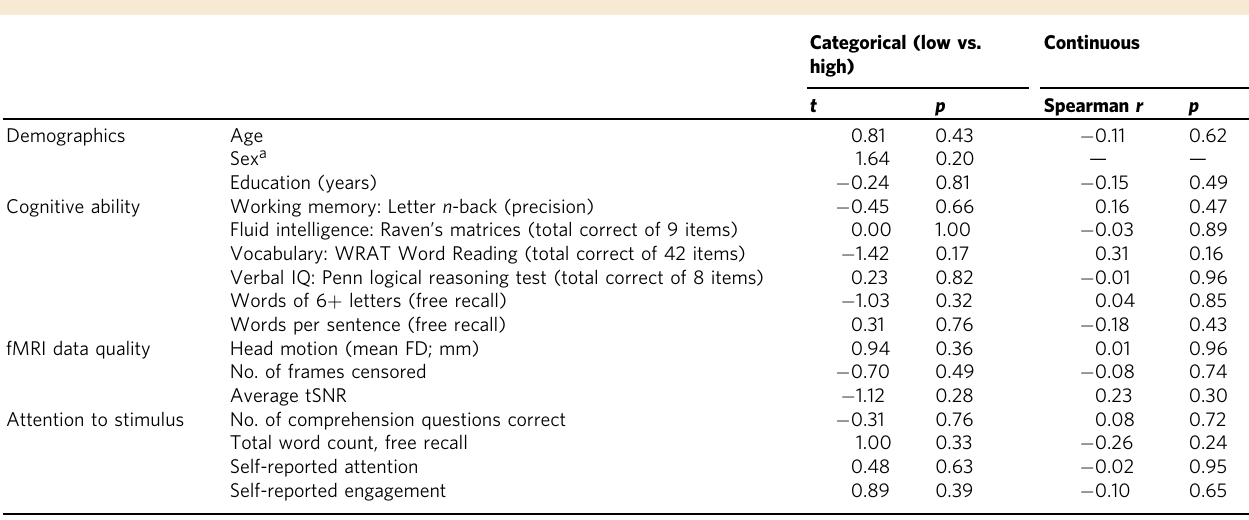
Table 1 Trait paranoia was unrelated to potential confounding variables